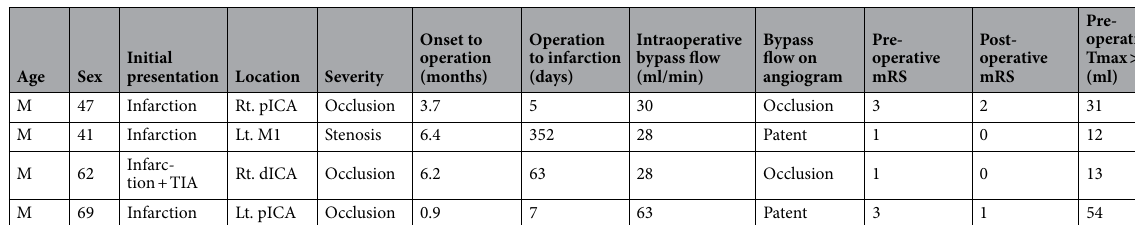
Table 3. Details of the 4 patients with postoperative recurrent cerebral infarction.